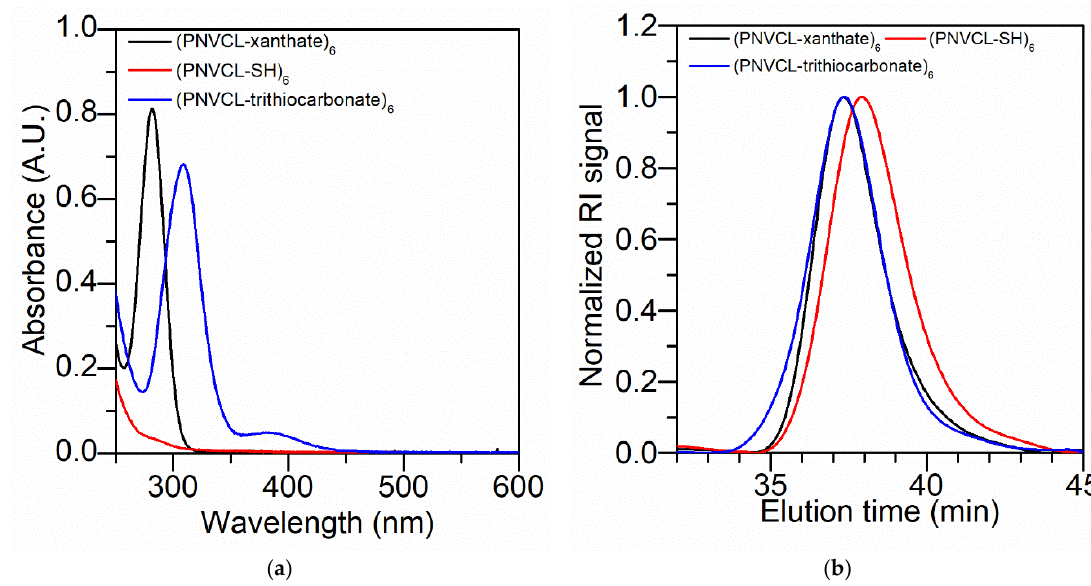
Figure 6. ( a ) UV-Vis spectra ( c = 1.0 mg/mL in ethanol) and ( b ) GPC traces in THF for (PNVCL-xanthate) 6 (Table S1, entry 2), (PNVCL-SH) 6 after aminolysis and (PNVCL-trithiocarbonate) 6 six-arm polymers. In Figure 6b, the GPC traces of (PNVCL) 6 star polymers with xanthate, thiol and trithiocarbonate groups are shown. The chromatogram of the thiol end sample ( M n GPC = 31,190 g/mol, Ð = 1.25) is shifted at a longer retention time and slightly higher molecular weight, but after the postfunctionalization, the position of the peak of the trithiocarbonate polymer ( M n GPC = 27,500 g/mol, Ð = 1.2) was practically the same as that of the starting xanthate polymer ( M n GPC = 26,900 g/mol, Ð = 1.13, Table S1, entry 2), although the dispersity increased slightly. The possibility of unwanted thiol coupling is always present, especially during the purification process of the thiol end-capped polymers. Figure 7. At 7.33 ppm a multiplet peak is observed that corresponds to aromatic hydrogens, and its presence proves the efficient functionalization of the trithiocarbonate group in the polymer.